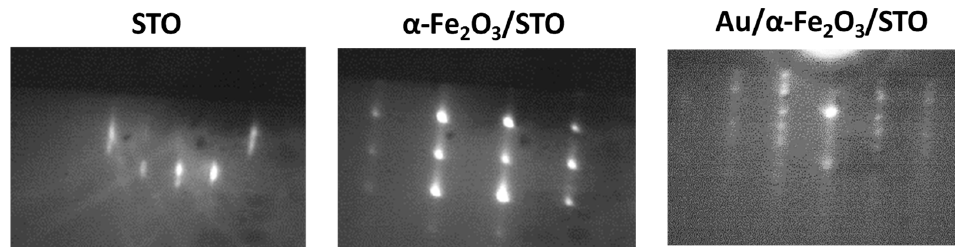
Figure 2. Representative RHEED patterns of the clean STO(111) substrate, α -Fe 2 O 3 thin films grown on STO(111) substrate and Au islands grown on α -Fe 2 O 3 /STO(111) system. During the deposition process of both α -Fe 2 O 3 and Au layers, intense patterns with smooth diffraction stripes are identified.